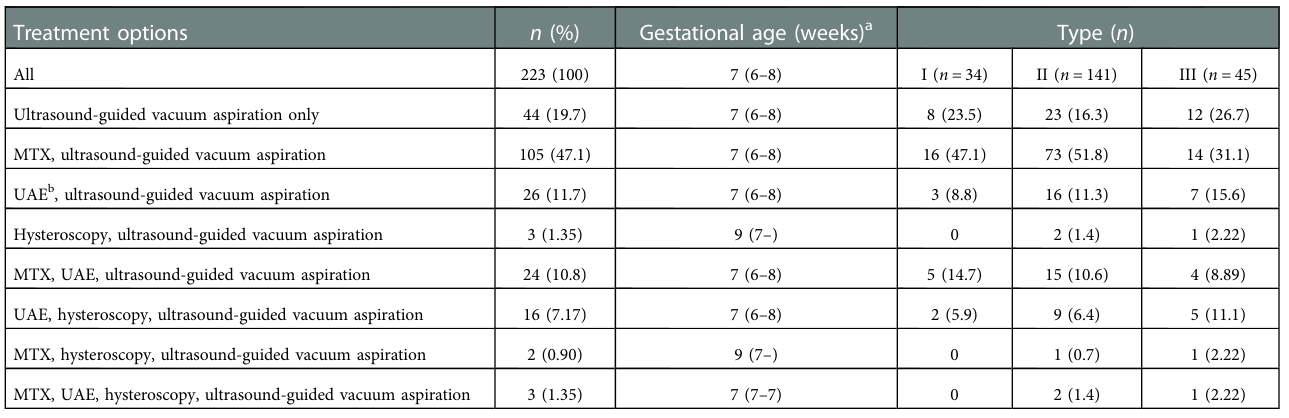
TABLE 1 Treatment modalities employed for cesarean scar